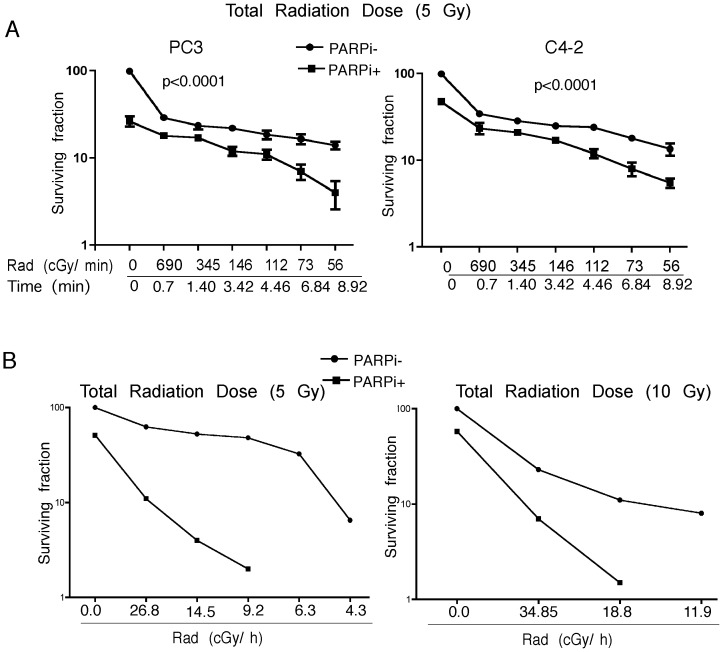
LDR is effective in sensitizing PCa Cells.
A, Clonogenic survival assays were performed for PC3 (left panel) and C4-2 cells (right panel) at different dose-rates ±1.25 µM rucaparib. B, C4-2 cells were exposed to different dose rates of radiation from an Ir-192 source ±2.5 µM rucaparib. A total radiation dose of 5 Gy (left panel) and 10 Gy (right panel) was delivered; therefore the time of exposure differed for the various dose-rates used. Error bars represent SD of mean (n = 3).